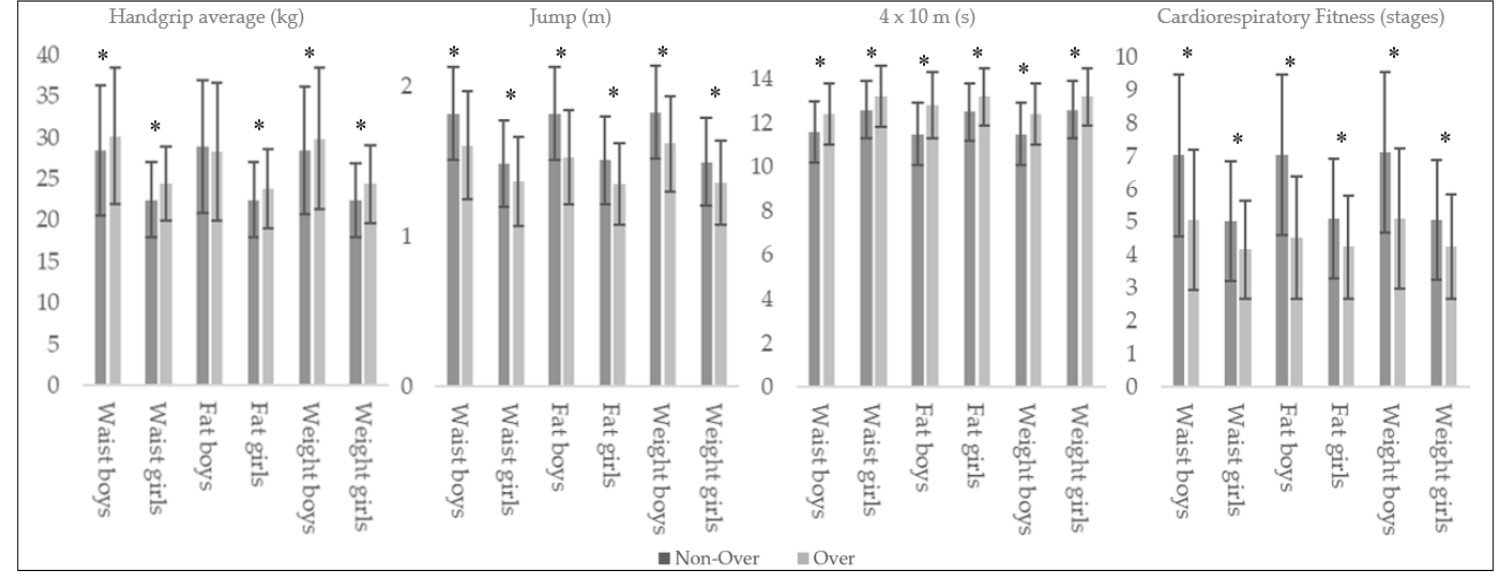
Figure 3. Physical fitness values in over and non-over boys and girls according body composition parameters. * Statistical difference between groups ( p < 0.05).